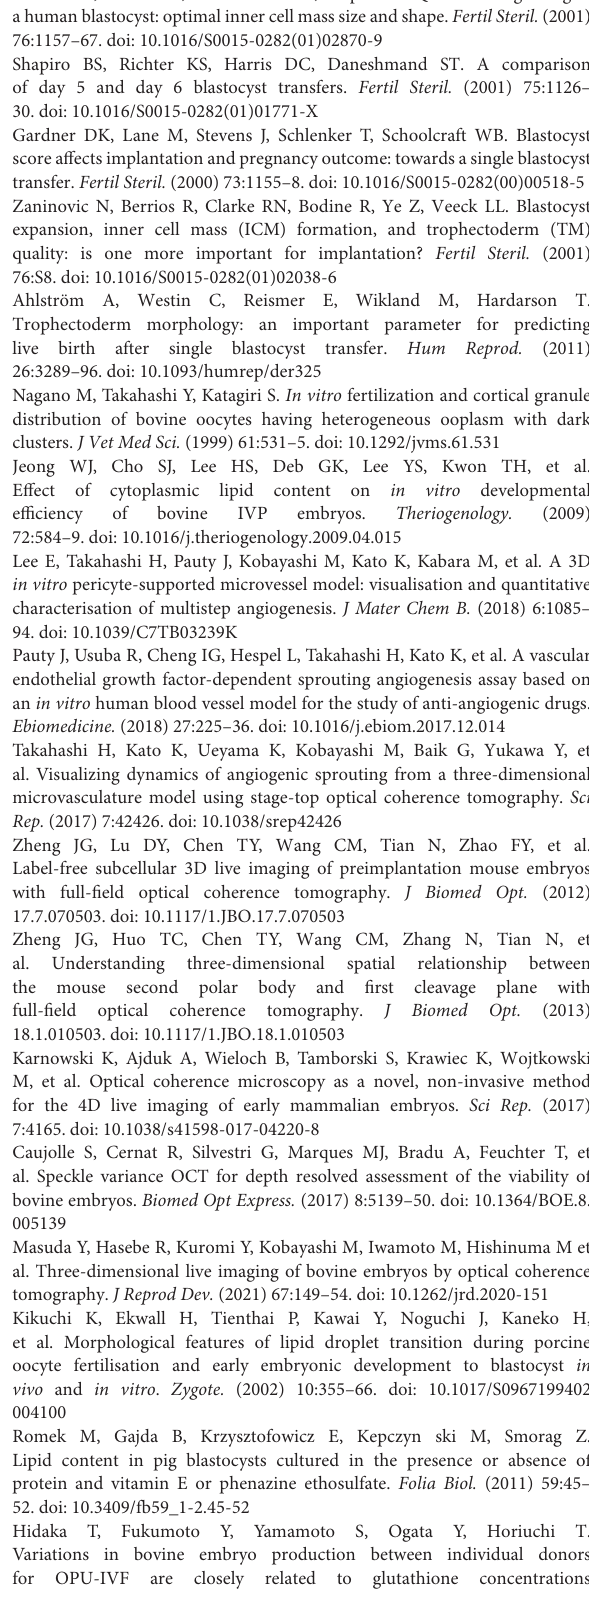
Frontiers in Veterinary Science |